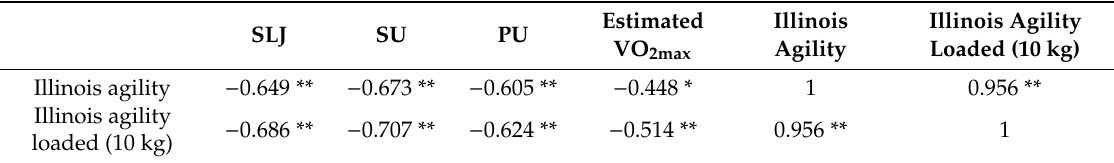
Estimated Illinois Illinois Agility VO 2max Agility Loaded (10 kg)